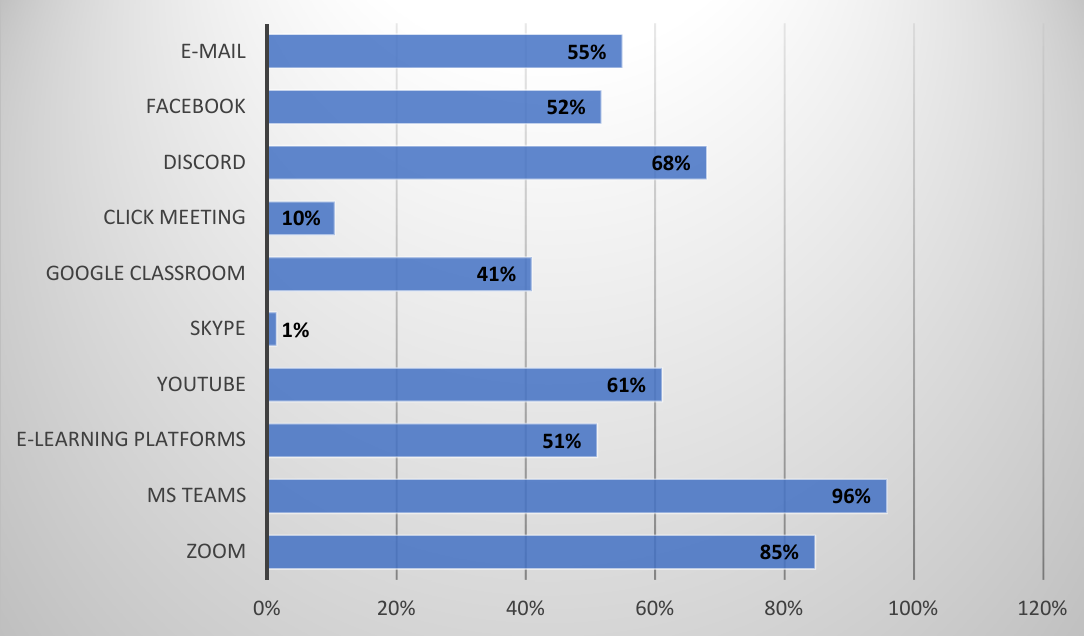
Figure 3. Increase in knowledge (in percentage points) about a given e-learning tool from the pre- pandemic period of COVID-19 to current days. Based on the results, it was concluded that before the pandemic, students mainly had knowledge of services for transmitting/sharing content in the form of videos, photos, and other materials, as well as for communication. More than half of the respondents showed knowledge of using YouTube (61%), Discord (54%), e-mail (53%) and Facebook (52%) in e-learning. Innovative e-learning tools allowing for synchronous or asynchronous communication with students and conducting classes via the Internet were known to slightly more than 20% of students—this applies to tools such as Zoom, MS Teams and e- learning platforms used by universities.